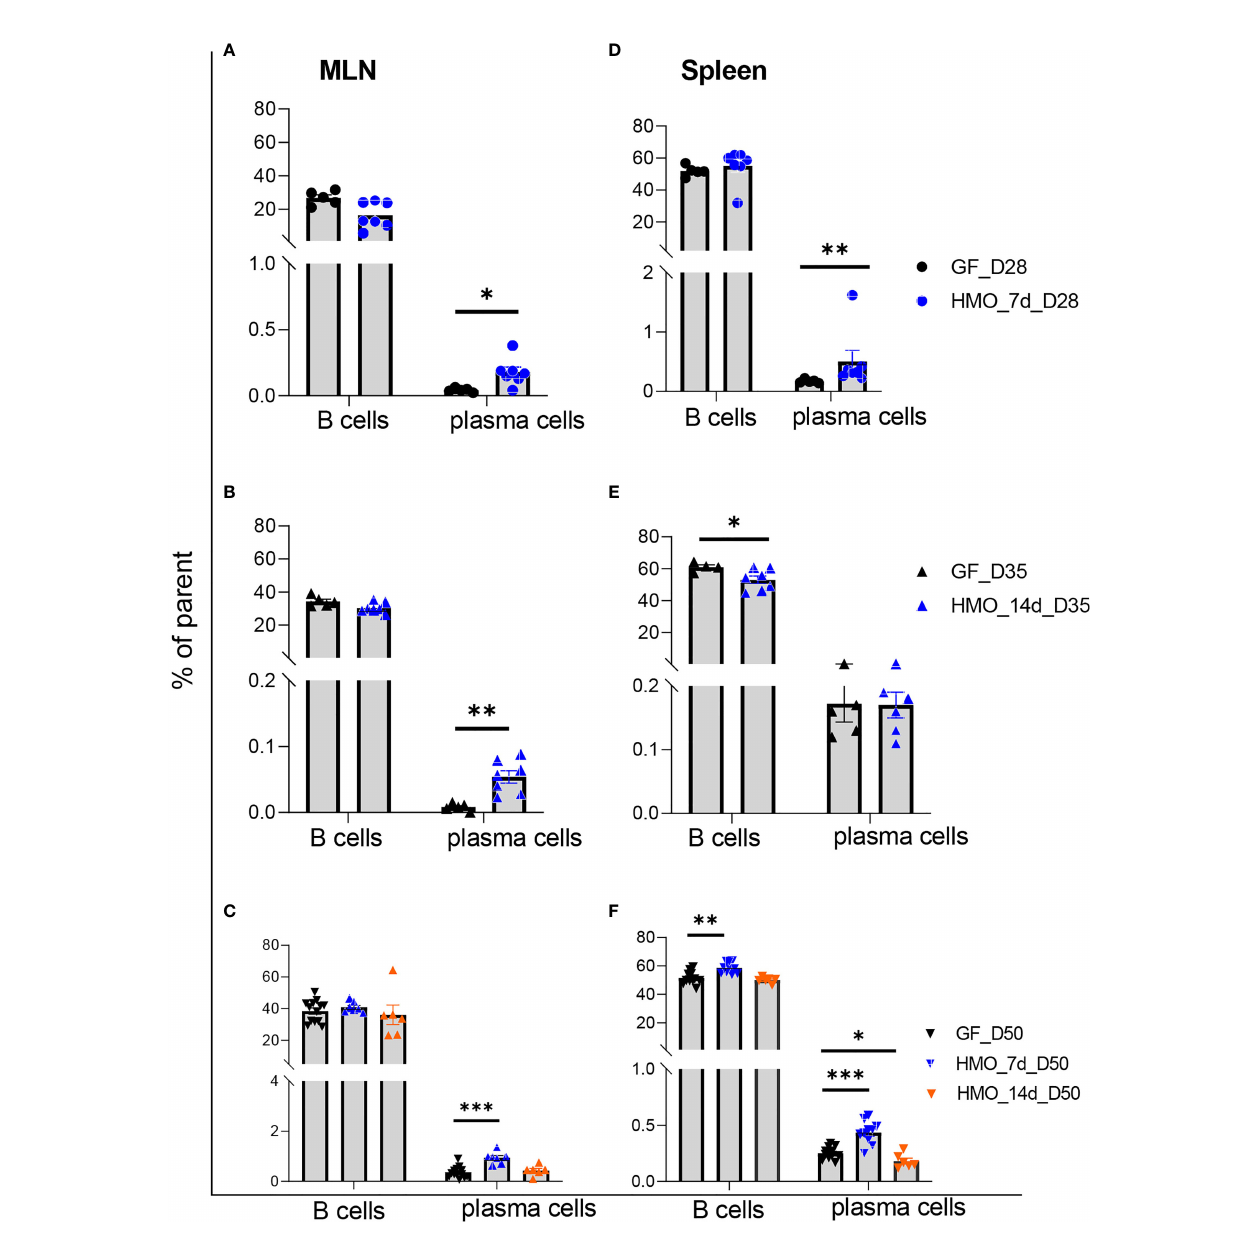
FIGURE 7 | B cells (B220+) and plasma cells (B220- CD138+) in MLN and the spleen following HMO administration. (A – C) B cells and plasma cells in MLN. (D – F) B cells and plasma cells in the spleen. Data are shown as the percentage of the respective parent population ( Supplementary Figure 1B ). Each dot represents a mouse, and data are shown as mean ± SEM. Statistical analysis was performed using the Mann – Whitney test in GraphPad Prism Version 9.3.1 (www.graphpad.com). Statistical signi fi cance: *** p<0.001, **p<0.01, *p<0.05, ns, not signi fi cant. Groups: Control (GF_D28, GF_D35, and GF_D50) = GF mice euthanized either at 28 days of age (n= 5; M=2, F=3) or 35 days of age (n= 5; M=2, F=3) or 50 days of age (n= 16; M=8, F=8) respectively; HMO_7d_D28 (n= 7; M=3, F=4) = GF mice that received 100 m l of HMO through 7 consecutive days and euthanized at 28 days of age; HMO_14d_D35 (n= 7; M=3, F=4) = GF